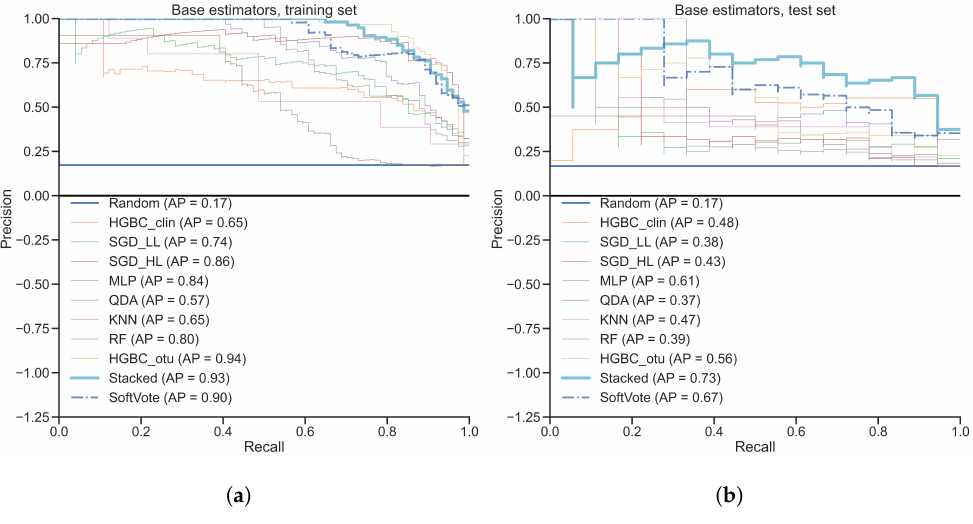
Figure A6. PR curves for stacked model applied on inflammatory bowel disease dataset with additional clinical features. ( a ) Training set; ( b ) Test